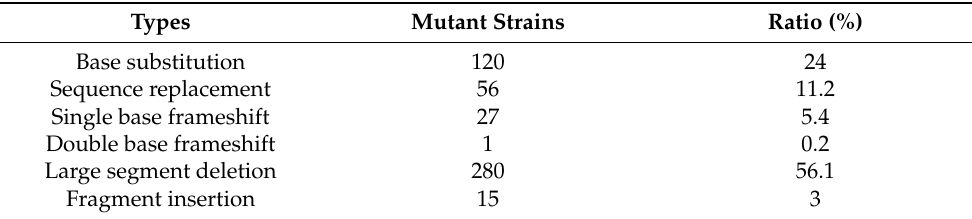
Table 2. Statistics of spontaneous mutation types of rpsL